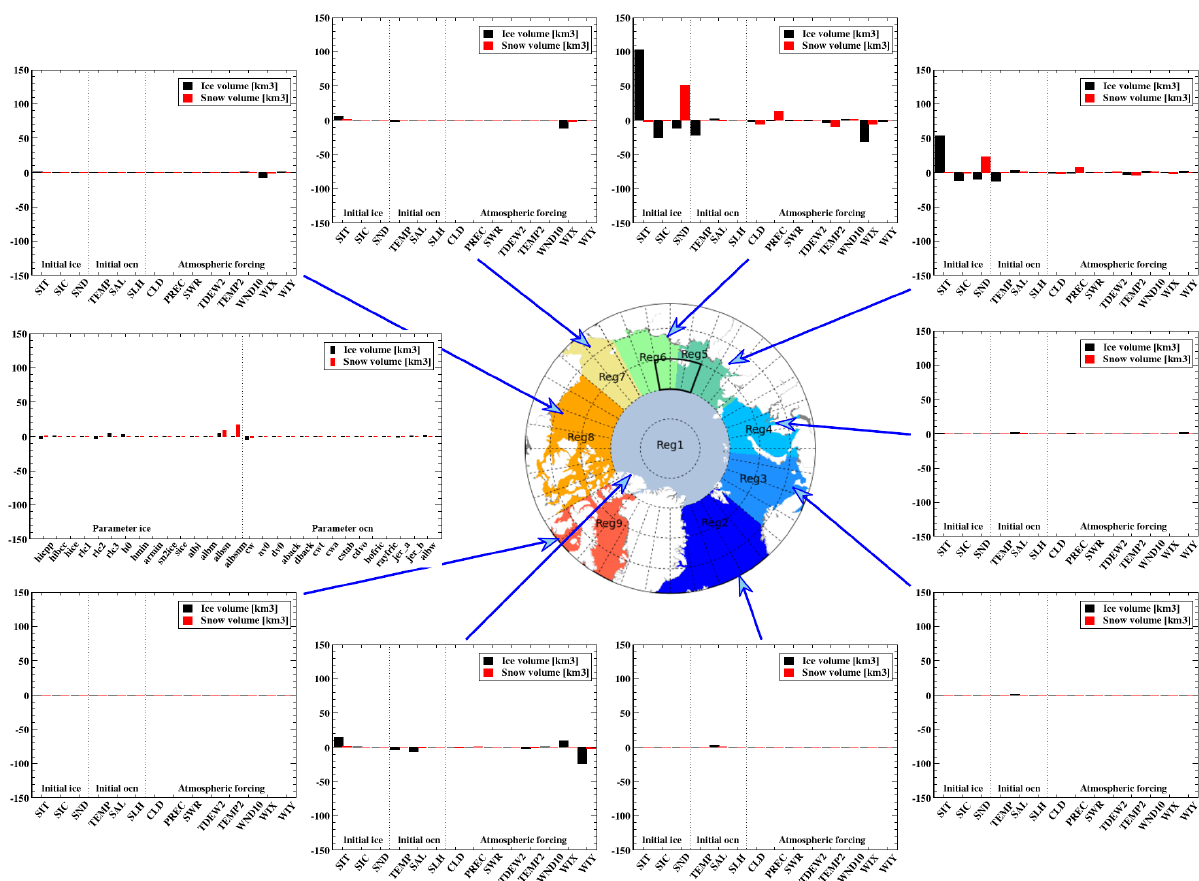
Figure 16. As Fig. 14 but for the sensitivities of the sea ice (SIV) and snow (SNV) volume over the target region, outer New Siberian Islands (ONSI), on the control vector (target